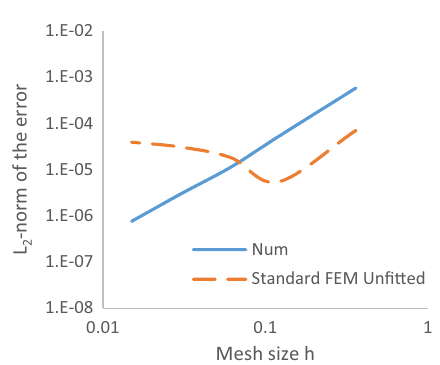
Fig. 17 Plot of the L 2 -norm of the error and comparison with the standard FEM with an unfitted mesh